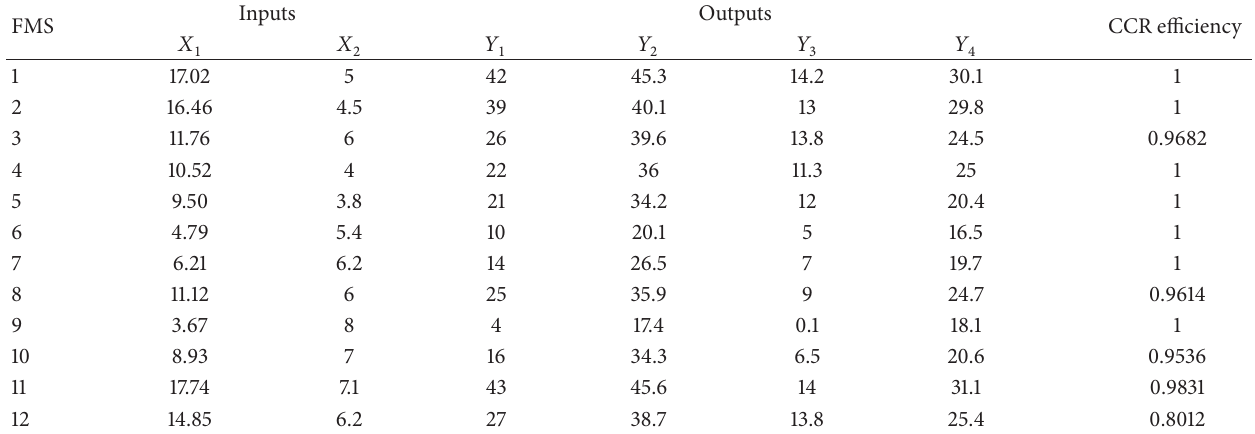
Table 1: Data and CCR efficiency for Example 1.